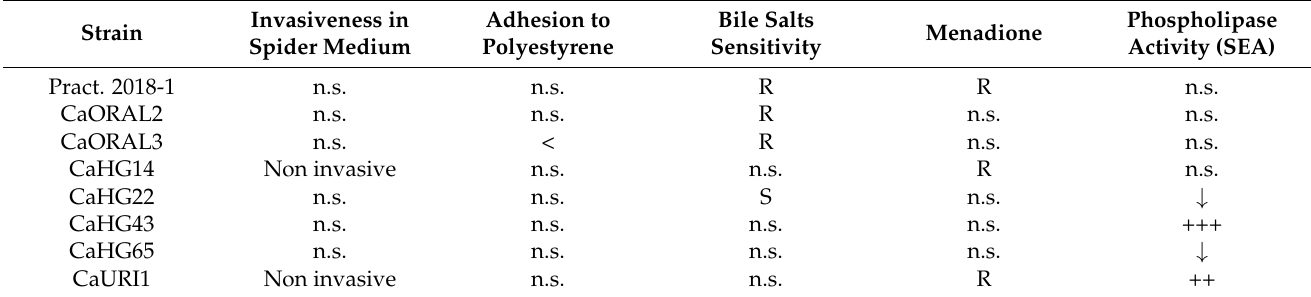
Figure 2. Competitive colonization assays. CaORAL3 and CaHG43 strains were inoculated in a 1:1 ratio with SC5314-RFP in 3 mice by gavage. The time course of fungal colonization load was followed by CFUs counting of stools in SD-chloramphenicol medium. Antibiotic treatment was removed at day 17. Figure S1 shows the colonization load for the other six selected C. albicans strains in competition with the SC5314-RFP. Table 3. Summary of phenotypic characteristic displayed by the selected C. albicans isolated in comparison to standard SC5314-RFP. Only differences are shown in the table. S sensible, R resistant, <adhesion to polystyrene compared to SC5314-RFP, ↓ low phospholipase activity, +++ very high phospholipase activity, ++ high phospholipase activity, ns means no significant differences were observed.